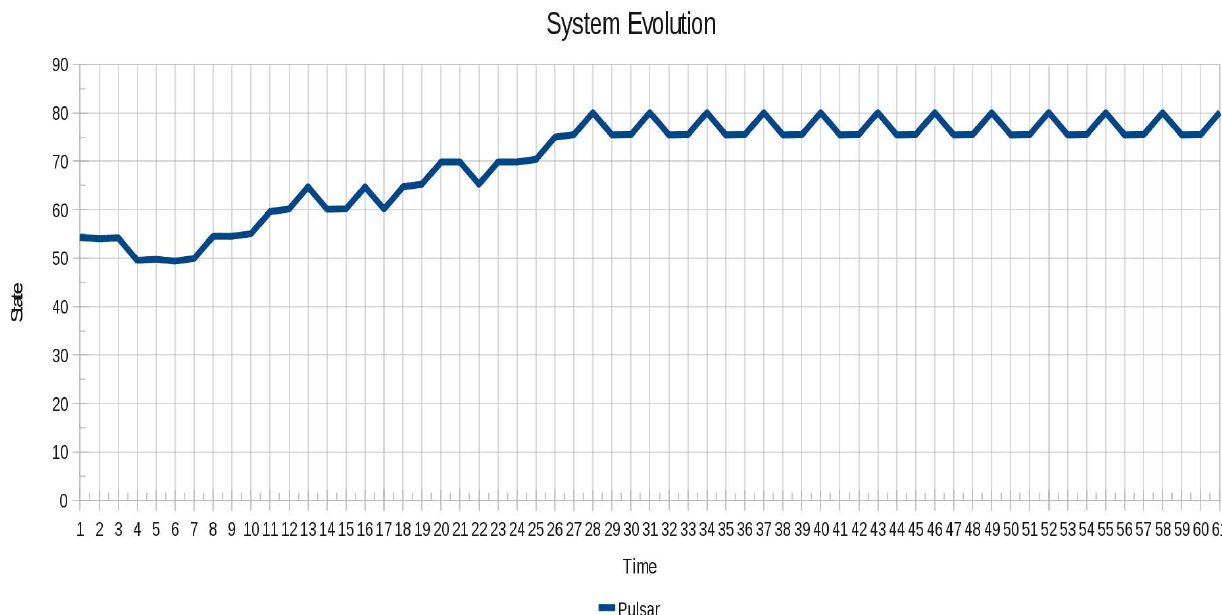
Figure 12. Oscillatory behavior of the instance 4